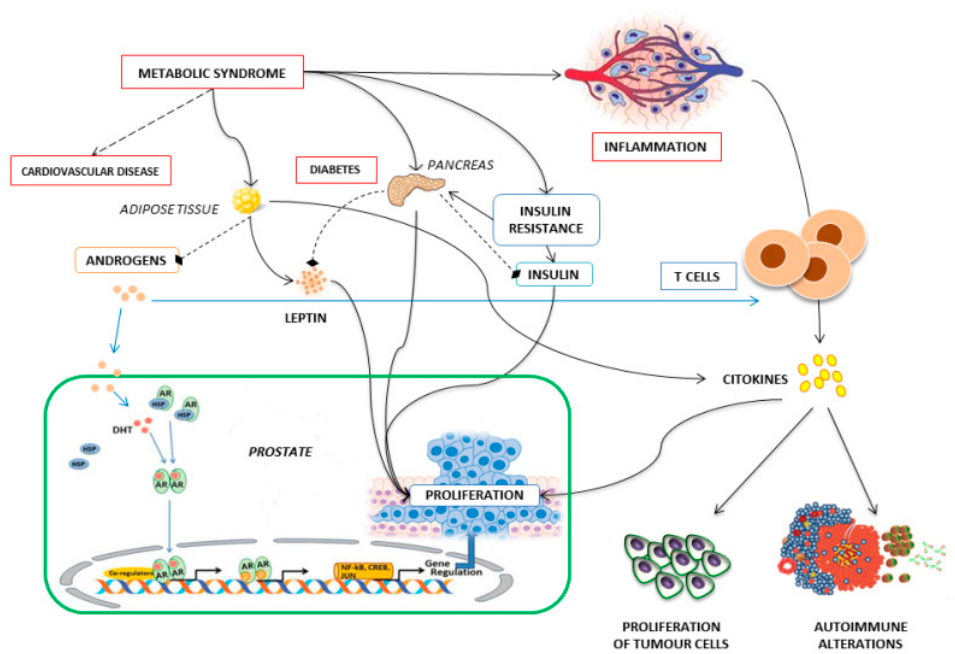
Figure 1. Alterations in the immune-metabolic crosstalk contribute to the development of autoimmune diseases. A relationship among the metabolic syndrome, inflammation and immune system leads to the secretion of cytokines that, in turn, may lead to an uncontrolled cell proliferation and autoimmune alterations.